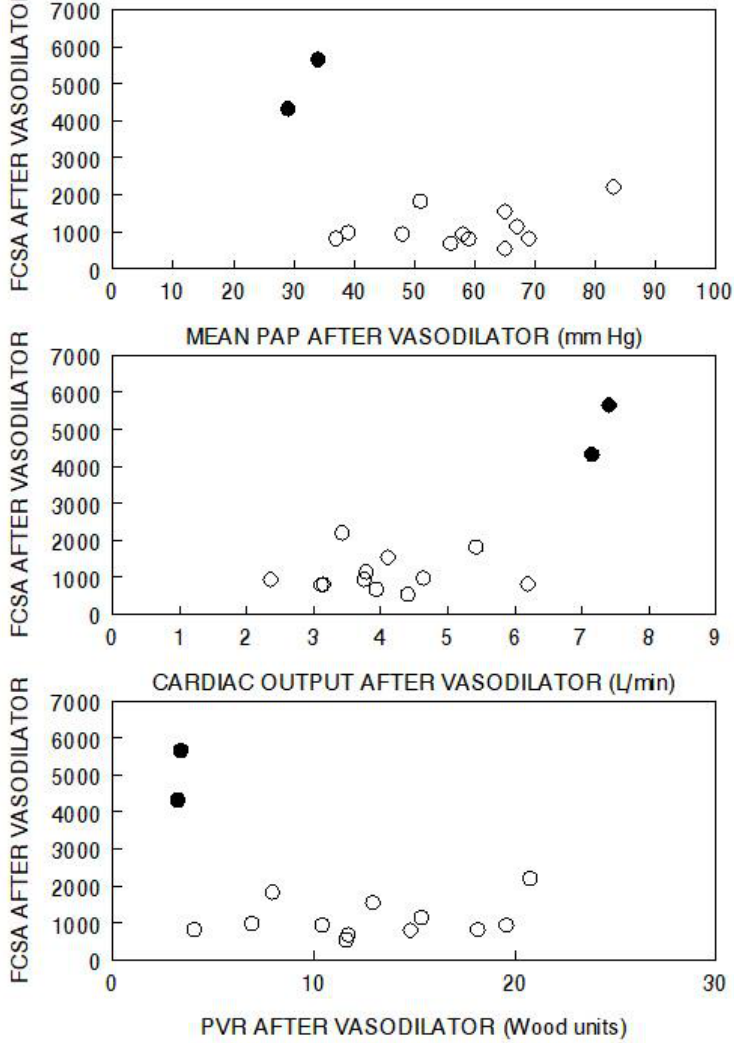
Figure 2. Functional capillary surface area normalized to body surface area (FCSA, mL/min/m 2 ) in human lungs post acute vasodilator therapy, as compared to pulmonary artery pressure (PAP), cardiac output, and pulmonary vascular resistance (PVR) post vasodilator. The open circles represent “resistance” responders and the filled circles represent “pressure” responders. Data have been adapted from reference [32].